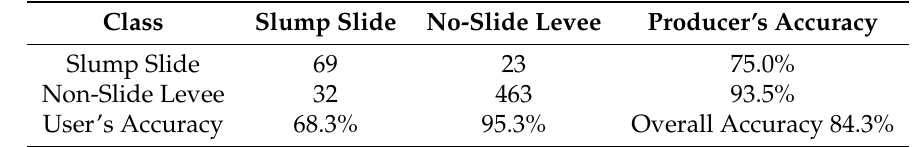
Table 4. Confusion matrix of SVM classifier output with GLCM features, σ = 1.7, and block size B = 9.